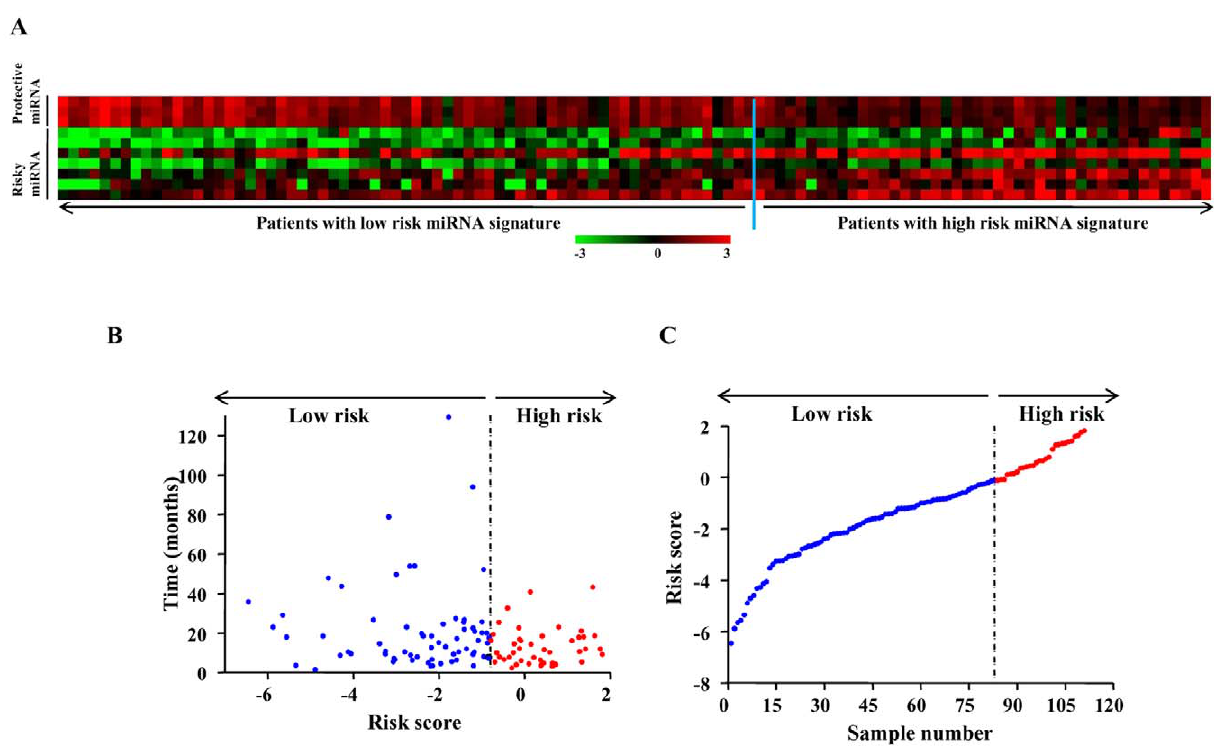
Figure 3. Ten miRNA Risk-Score Analysis of 111 GBM patients (test set). A ) Heat map of ten miRNA expression profiles of GBM patients; rows represent risky and protective miRNAs, and columns represent patients. The blue line represents the miRNA signature cutoff dividing patients into low-risk and high-risk groups. B ) Patient survival status along with risk score. C ) miRNA risk-score distribution of the GBM patients.